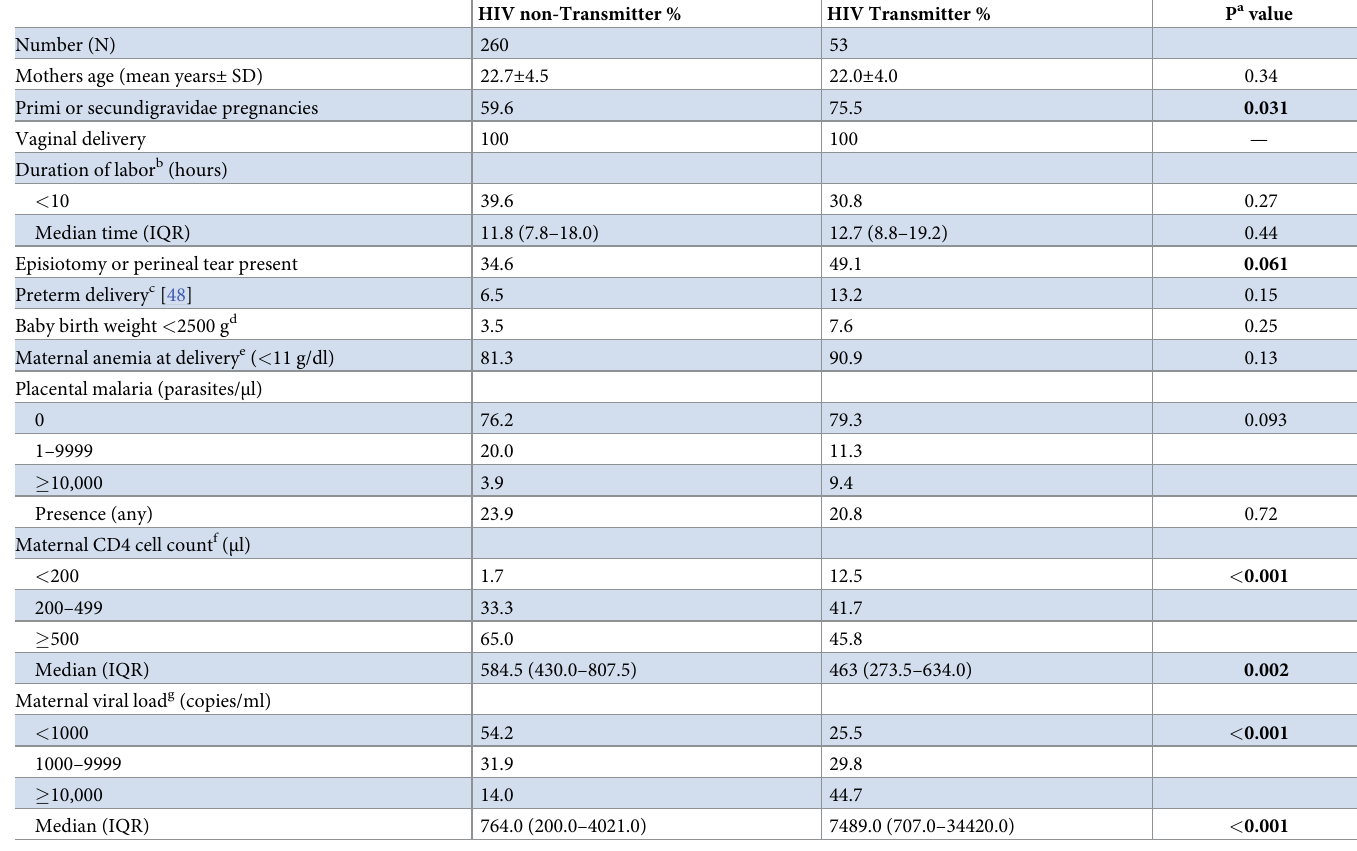
Table 1. Characteristics of perinatal HIV-1 transmission